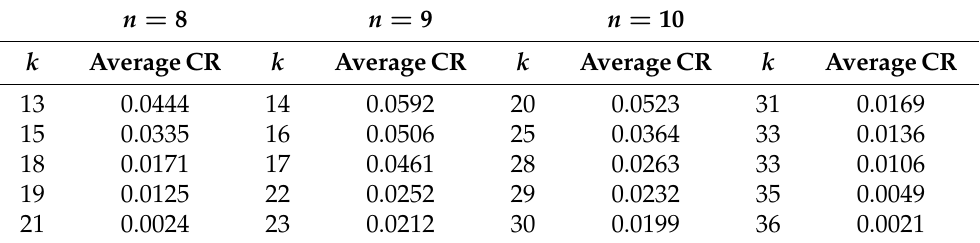
Table 7. Average CR of 10,000 modified consistent matrices for an arbitrarily large number of missing comparisons k with respect to matrix size n that continued from Table